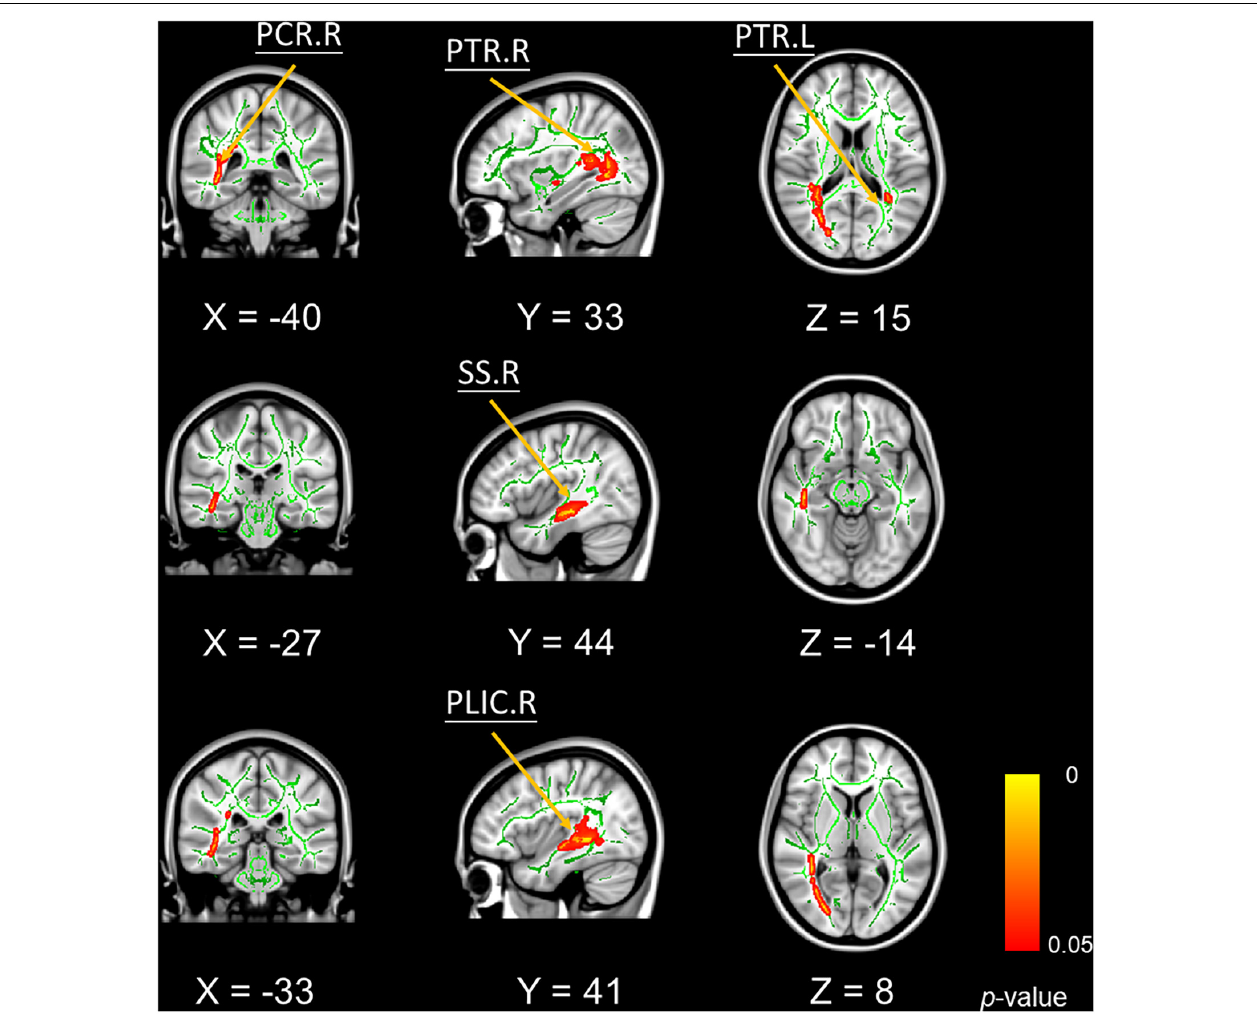
FIGURE 3 | Significant voxel-wise correlations between fractional anisotropy of white matter tracts and the outcomes of visual pattern test (5000 permutations, FWER correction, p < 0.05). Red color indicates the significant positive correlations. Abbreviations: PTR, posterior thalamic radiation; PCR, posterior corona radiate; PLIC, petro lenticular part of internal capsule; SS, sagittal stratum; R, right hemisphere; L, left